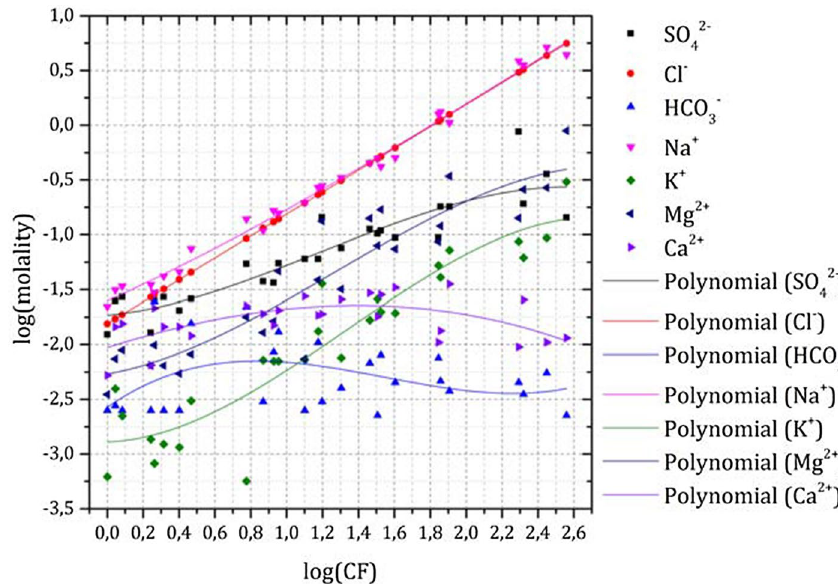
Fig. 6 Ion concentration dia- gram (Molality vs.